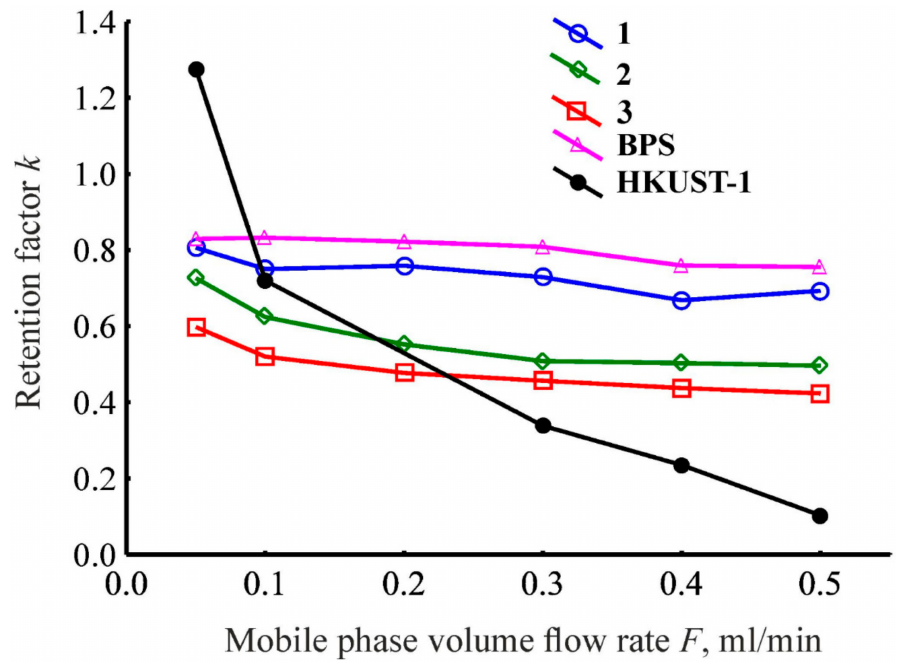
Figure 9. Dependences of the benzene retention factor on the volumetric flow rate of the mobile phase for the HKUST-1@BPS composites, the pristine HKUST-1, and bare BPS